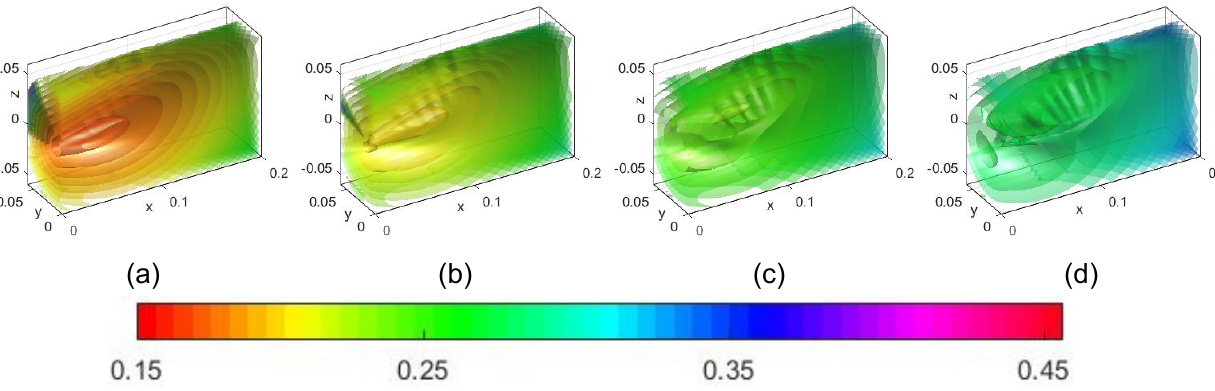
Figure 7. The PEFs of the variant arc-section and quasi-isotropic material, with a progressive prestress angle show that the lowest energy “bubble” drifts away from the main plane. The applied angle is (a) 1 θ c , (b) 1.1 θ c , (c) 1.2 θ c , and (d) 1.3 θ c . The critical angle in present variant is θ c = 1 . 216rad, as can be found in Table 2.